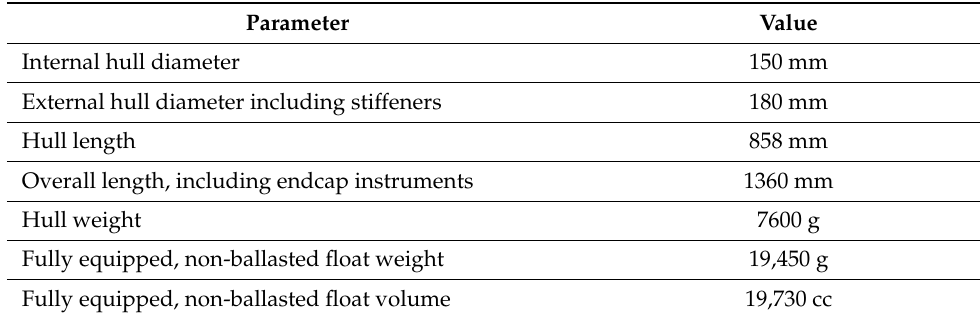
Table 1. Float main physical parameters. Parameter Value Internal hull diameter 150